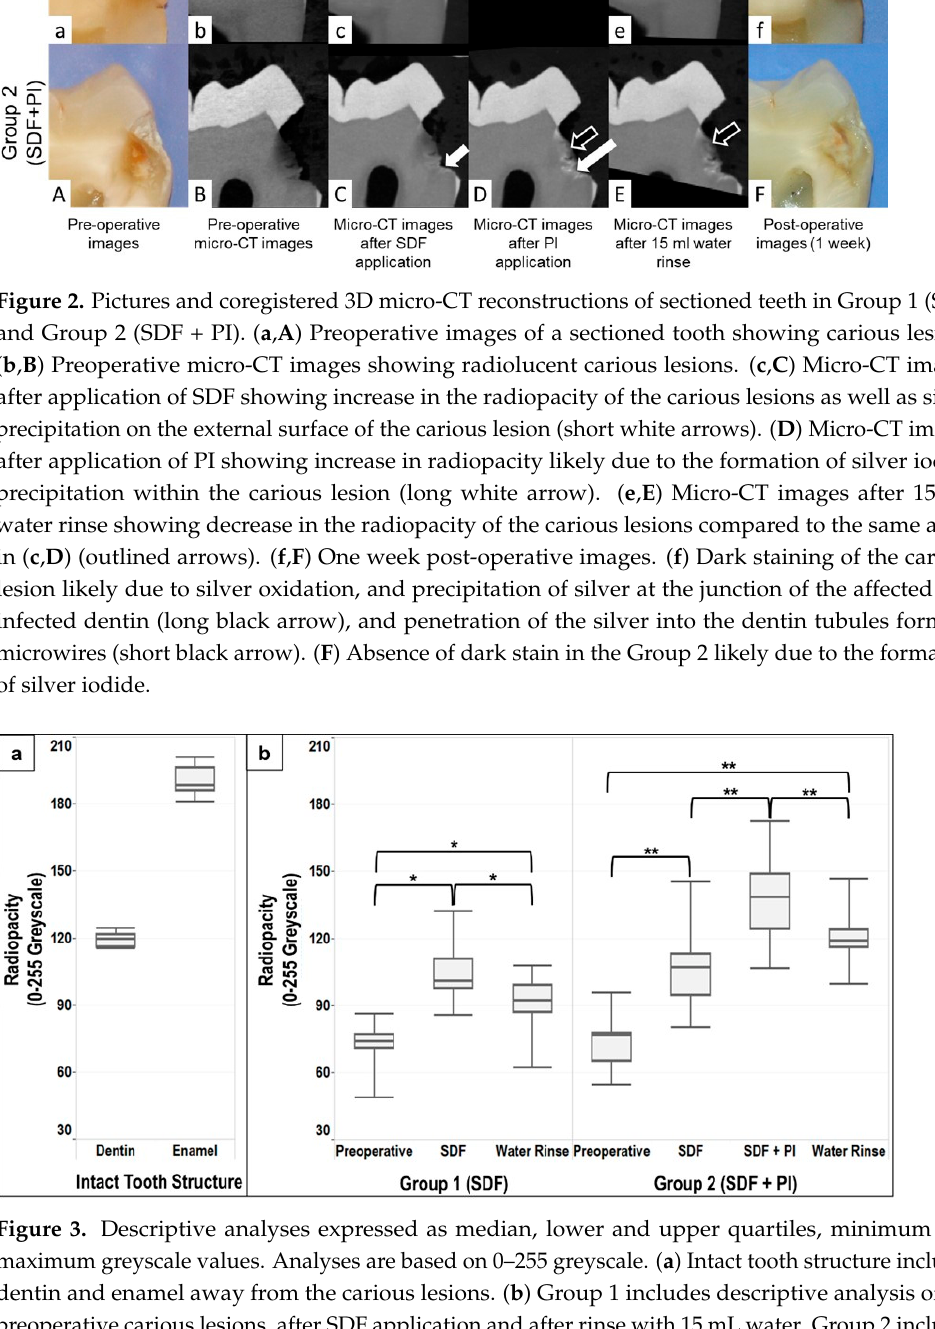
Figure 3. Descriptive analyses expressed as median, lower and upper quartiles, minimum and maximum greyscale values. Analyses are based on 0–255 greyscale. ( a ) Intact tooth structure includes dentin and enamel away from the carious lesions. ( b ) Group 1 includes descriptive analysis of the preoperative carious lesions, after SDF application and after rinse with 15 mL water. Group 2 includes descriptive analyses of the preoperative carious lesions, after SDF application, after PI application, and after rinse with 15 mL water. * p < 0.017 (adjusted p values for multiple comparisons in group 1), ** p < 0.008 (adjusted p values for multiple comparisons in group 2). Application of SDF alone resulted in a significant increase in the radiopacity of the carious lesions compared to the preoperative radiopacity in Group 1 and Group 2 ( p < 0.017 and p < 0.008, respectively) (Figure 3b). After SDF application, no difference was